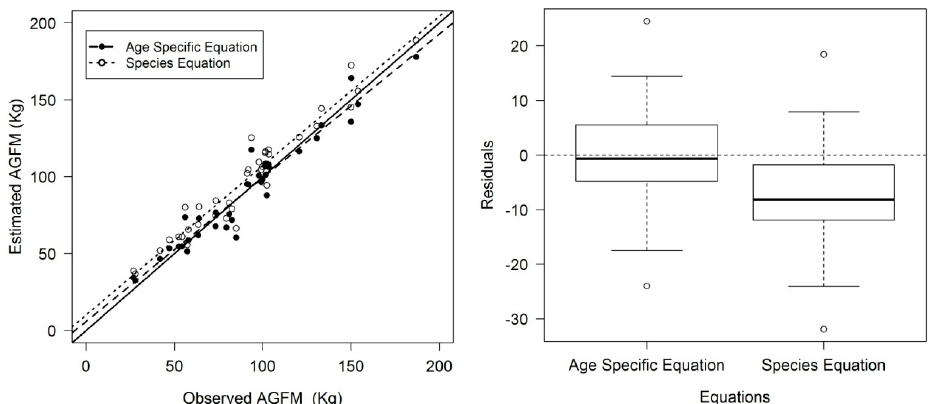
Figure 3. ( Left ) Comparison of allometric equations of above-ground fresh mass (AGFM) using the estimated values by “Species Equation” and “Age Specific Equation” for C 12 in relation to the observed values. ( Right ) Comparing the equations showing the differences between the residuals generated from “Species Equation” and “Age Specific Equation ” for AGFM with deviations around the mean.